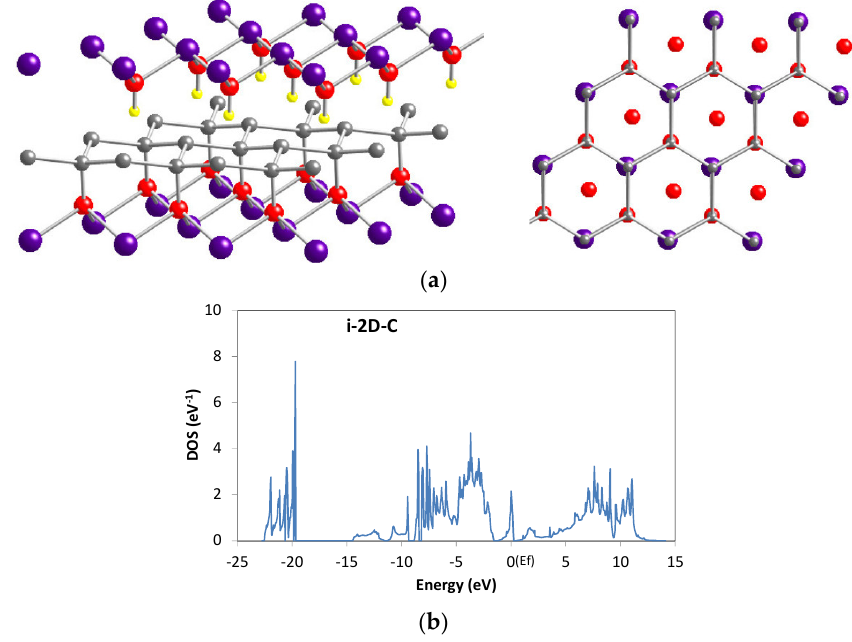
Figure 8. ( a ) Atomic structure of a 2D-C layer in Mg(OH) 2 . ( b ) DOS of Mg(OH) 2 with a 2D-C layer.